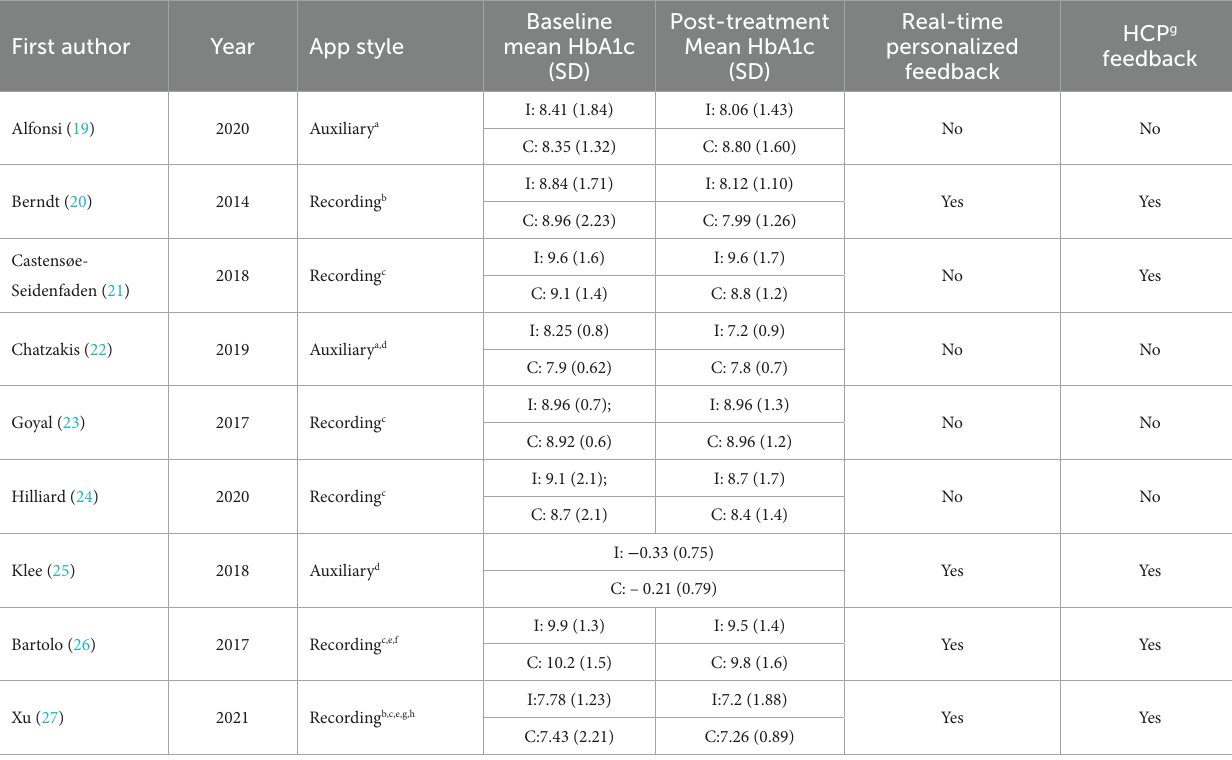
TABLE 2 Characteristics of mobile